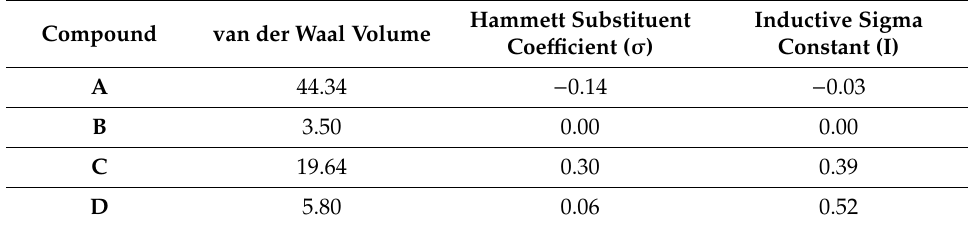
Table 2. Hammett substituent coefficient ( σ ) and the van der Waal volume of terminal X for compounds A – D.